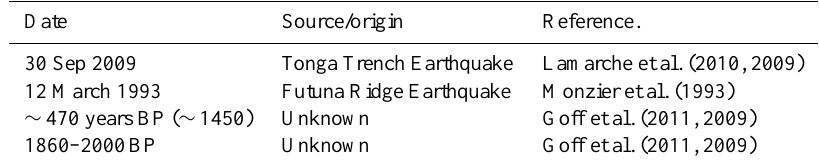
Table 2. Historical and palaeo-historical tsunami in Futuna